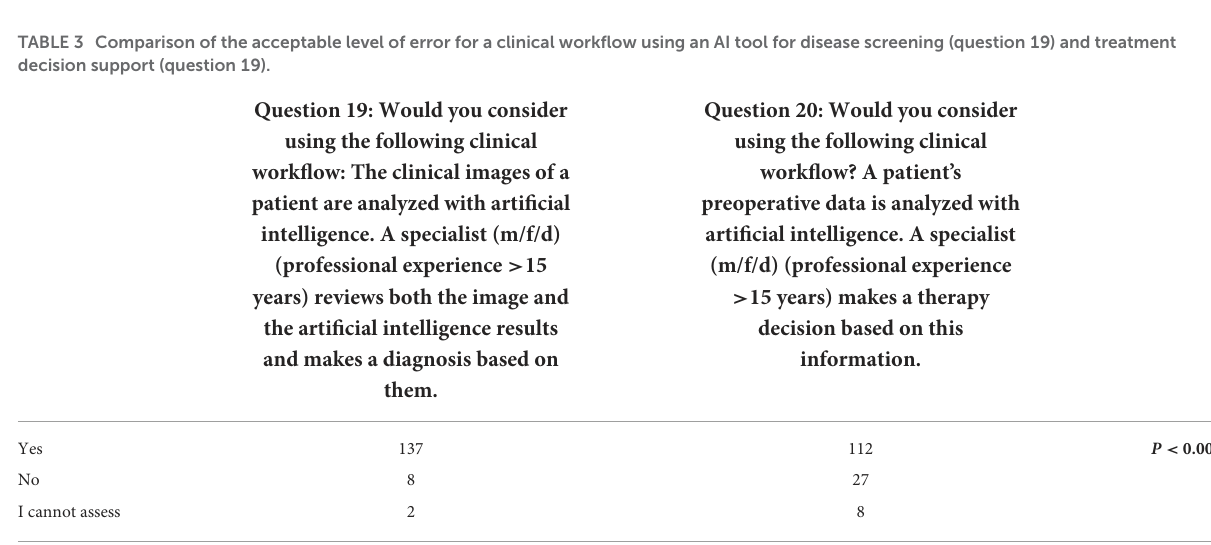
TABLE 3 Comparison of the acceptable level of error for a clinical workflow using an AI tool for disease screening (question 19) and treatment decision support (question